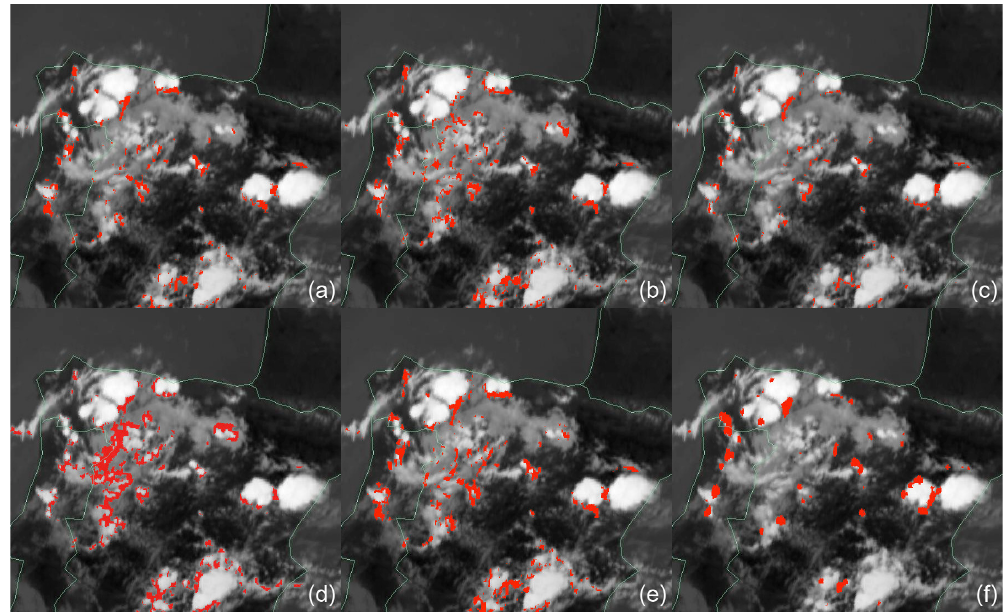
Fig. 2. Different masks for the six separate criteria listed in Table 3 for the same scene as in Fig. 1. Pixels plotted in red meet the individual thresholds for the defined criterion. (a) Criterion #1: 15min IR10.8; (b) #2: 30min IR10.8; (c) #3: freezing level IR10.8; (d) #4: WV6.2-